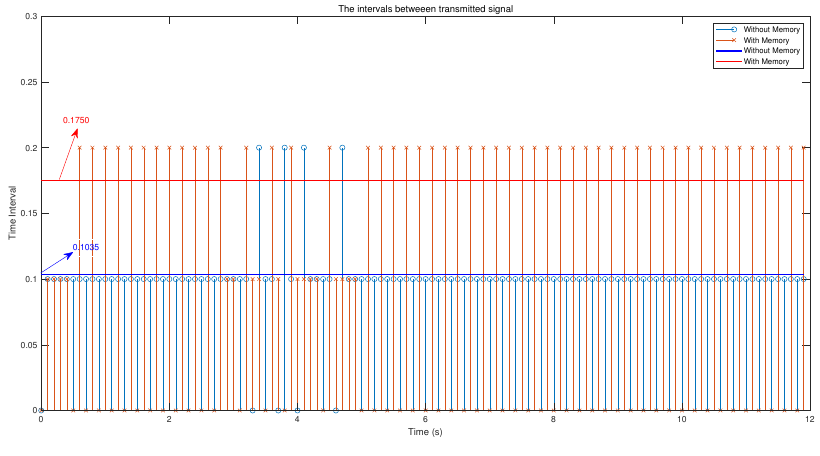
Figure 3. The intervals between consecutive signals.